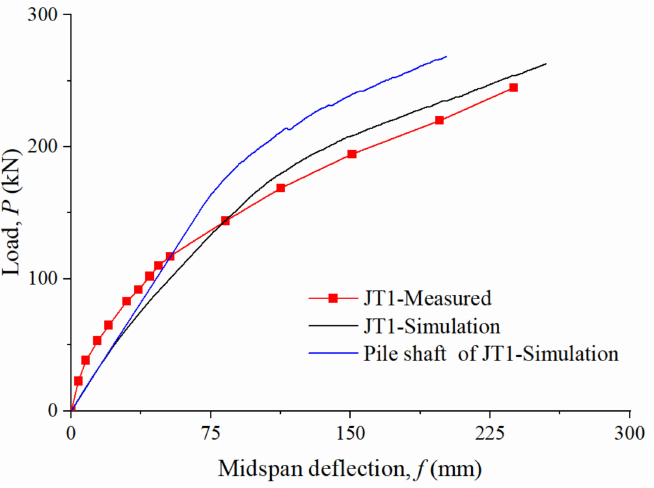
Figure 9. Comparison between numerical simulation and bending test.